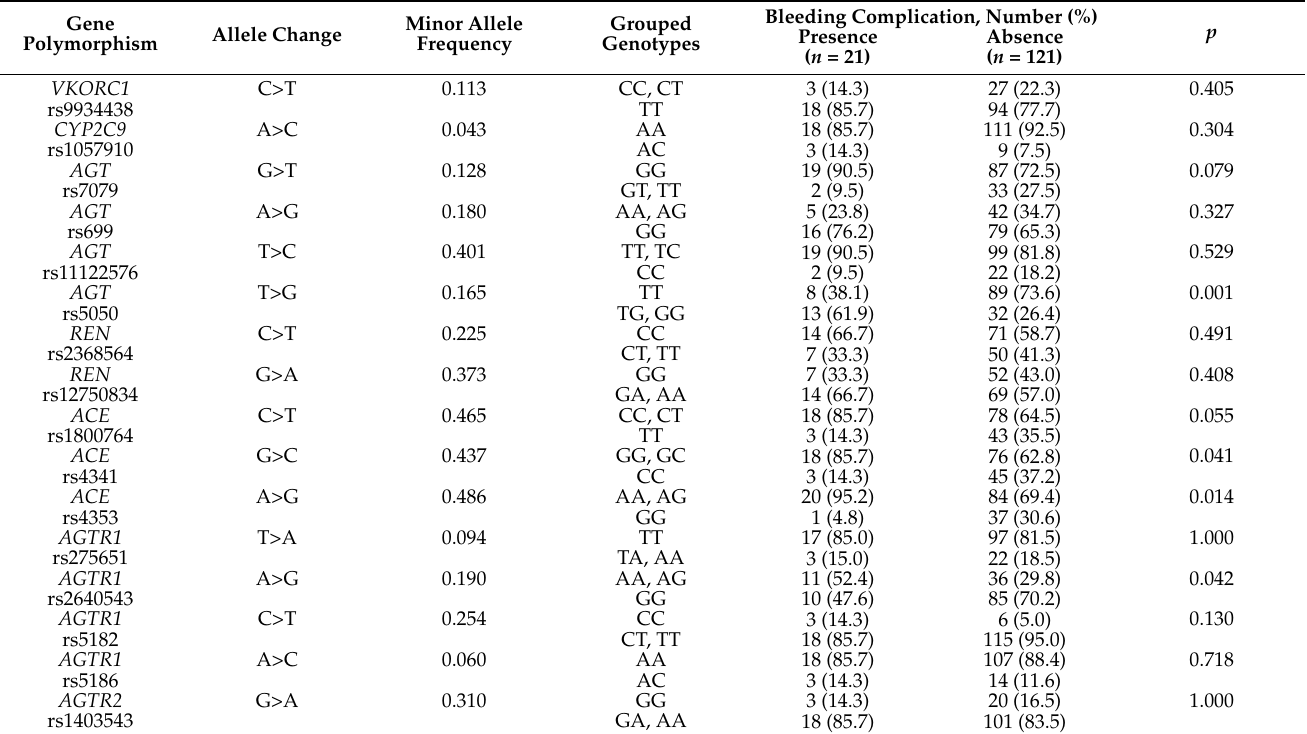
Table 2. Genetic factors associated with bleeding complications at therapeutic INR. Gene Minor Allele Polymorphism Allele Change